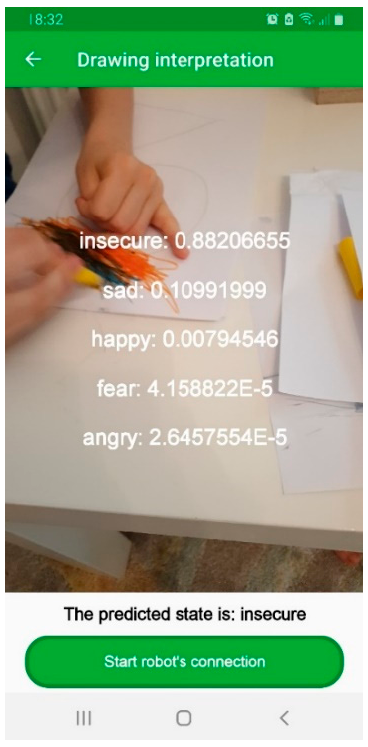
Figure 15. PandaSays state prediction when child was drawing.